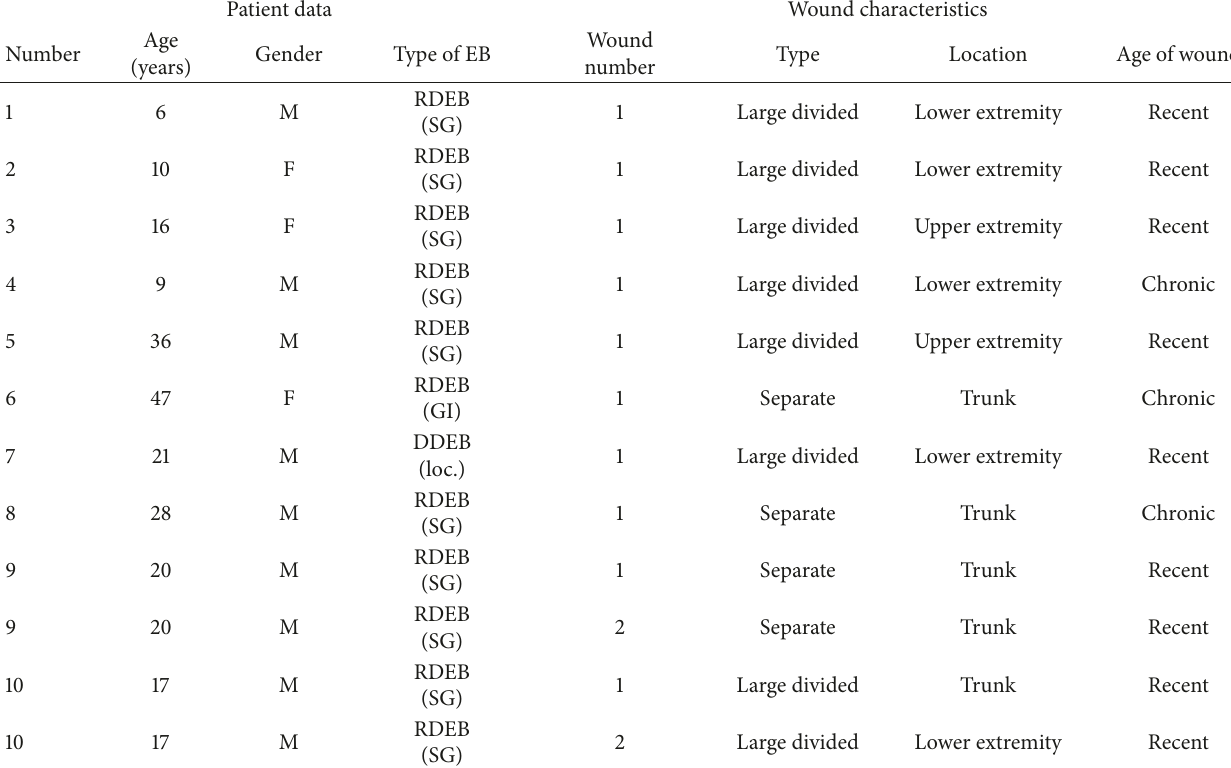
Table 2: Wound characteristics.